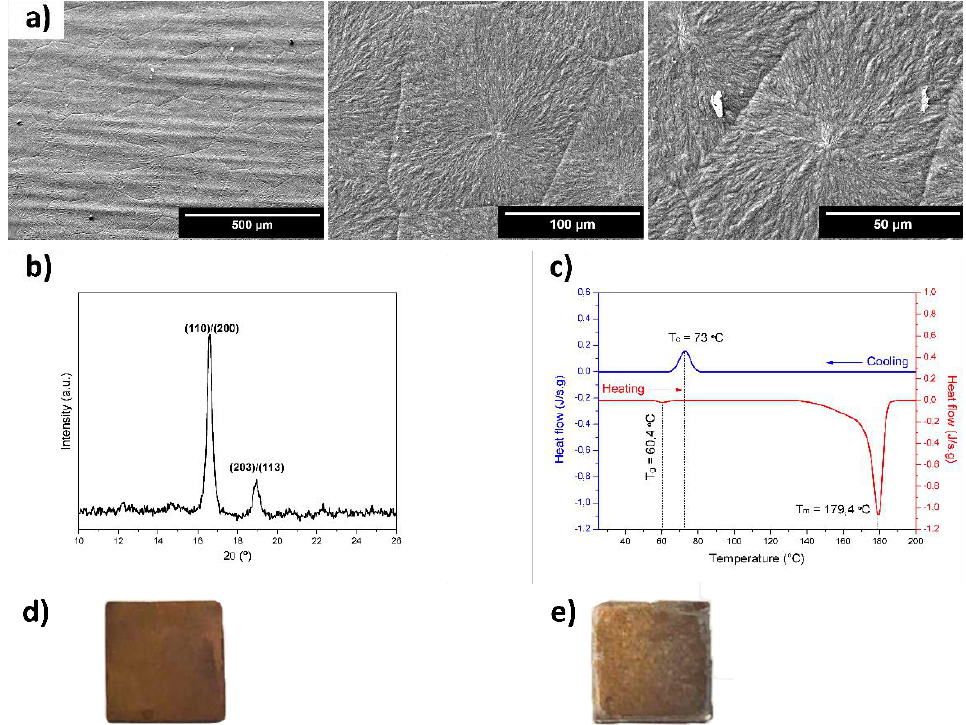
Figure 1. SEM micrographs of PLLA films. The presence of spherulites is noticed and the mean diameter size is 88.9 ± 1.7 µ m ( a ); XRD pattern of SS/SIL/PLLA samples with the presence of α -form crystallographic plans ( b ); DSC of PLLA films with the heating and cooling rate of 10 °C/min from room temperature to 200 °C under airflow. T m , T g , and T c are identified, and the degree of crystallization calculated is 48.8% ( c ). Images of 316SSL devices: ( d ) SS/SIL device and ( e ) SS/SIL/PLLA device.